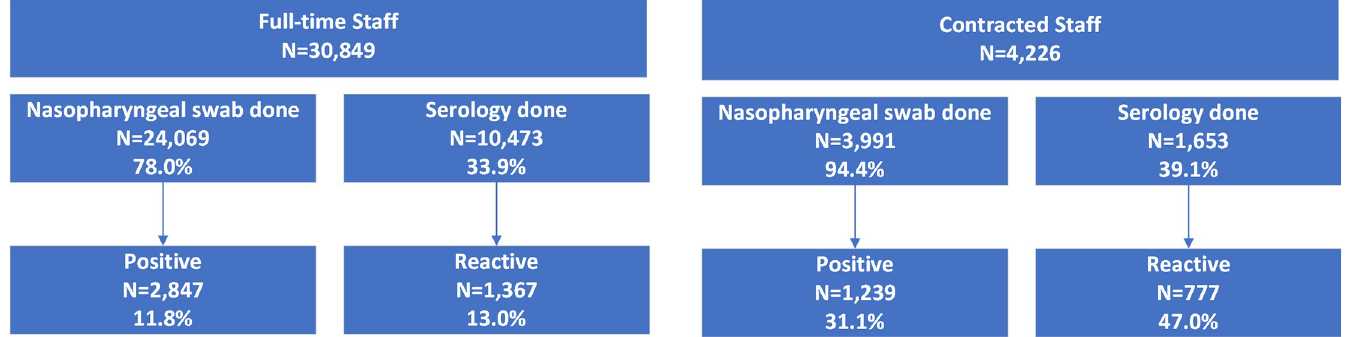
Fig 2. A flowsheet of full-time and contracted who were tested for SARS-CoV-2 infection by PCR on a nasopharyngeal swab and for SARS-CoV-2 antibody.